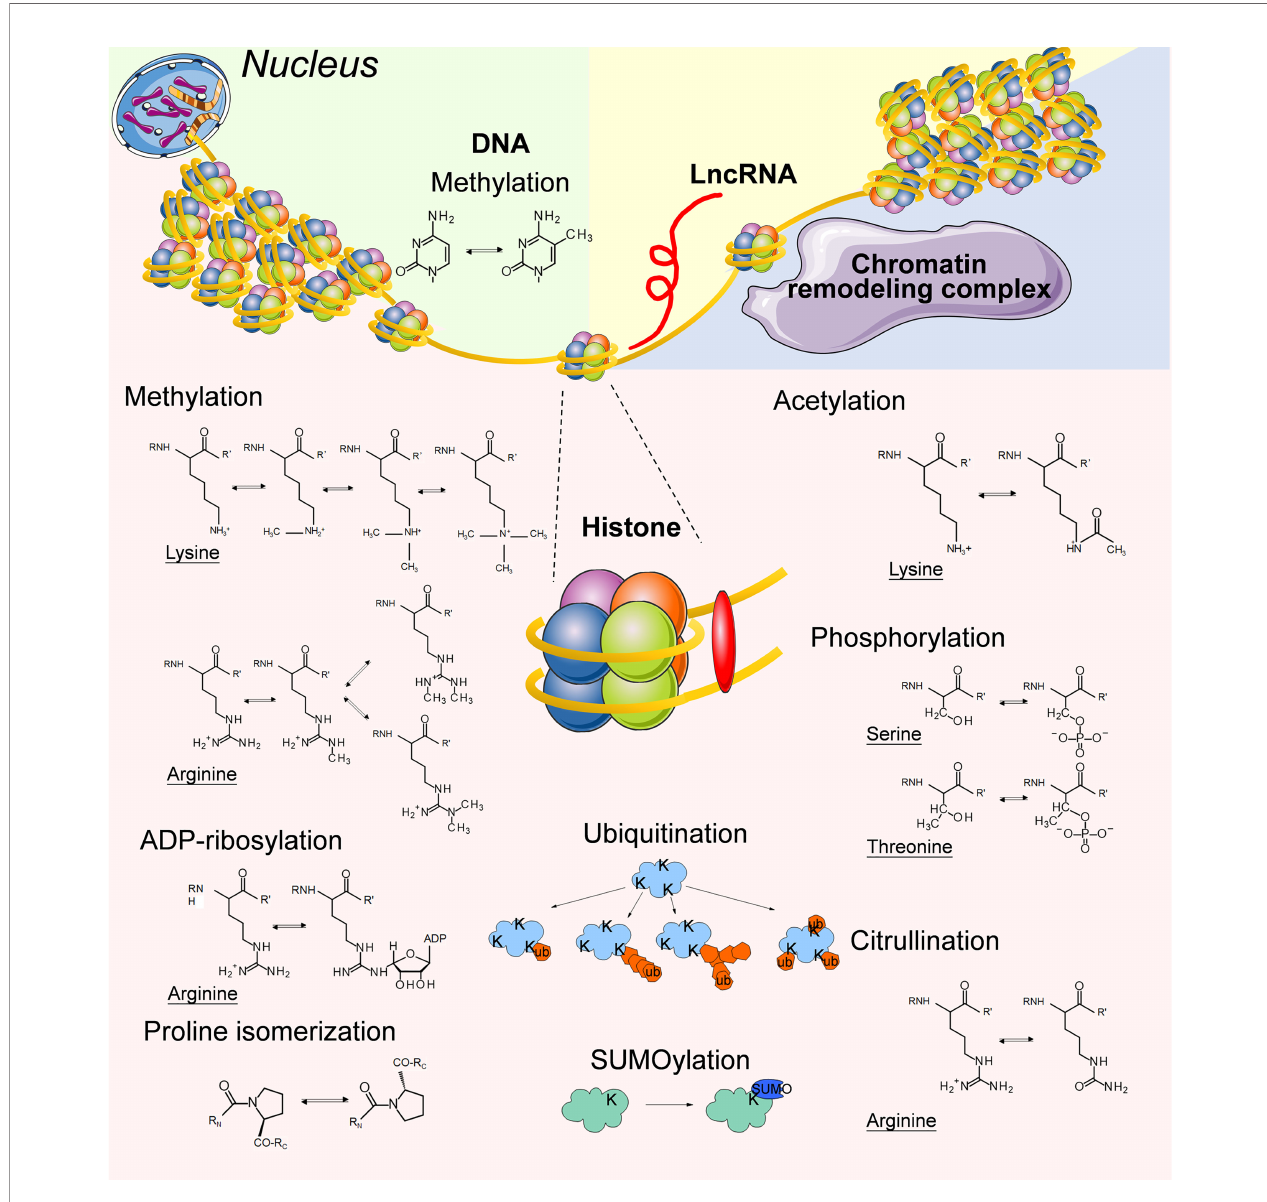
FIGURE 1 | Summary of the typical epigenetic modi fi cations on genomic DNA, Histone proteins and